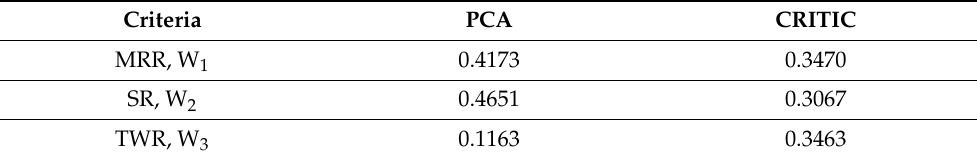
Table 14. Weight fractions of different responses: PCA and CRITIC.